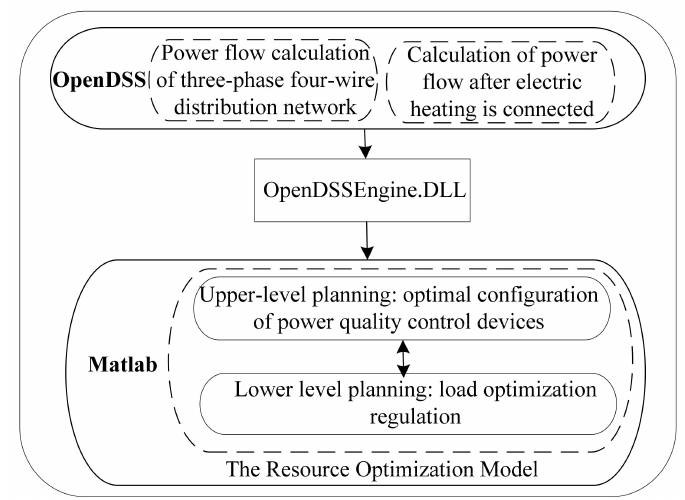
Figure 5. Matlab and OpenDSS co-simulation